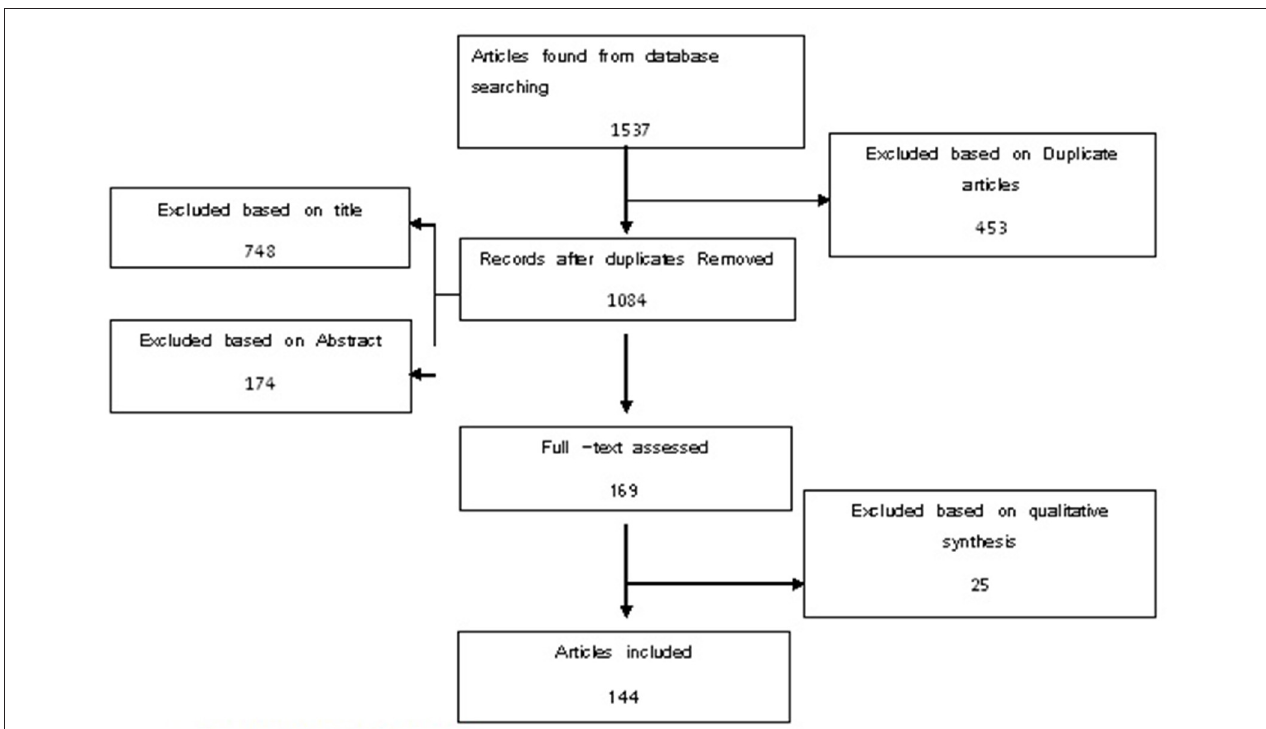
FIGURE 1 | Search and screening